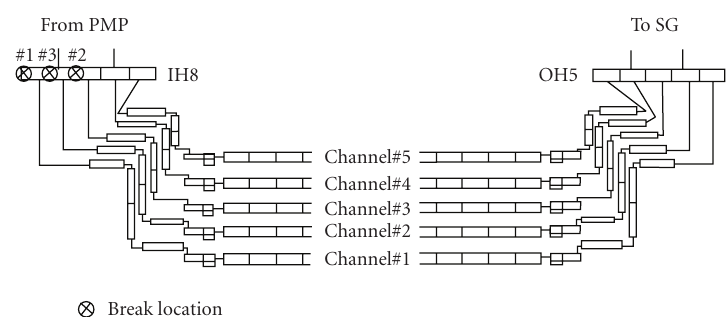
Figure 14: RELAP5 thermal hydraulic nodalization of manifold headers for CANDU-6 Inlet manifold break analysis.